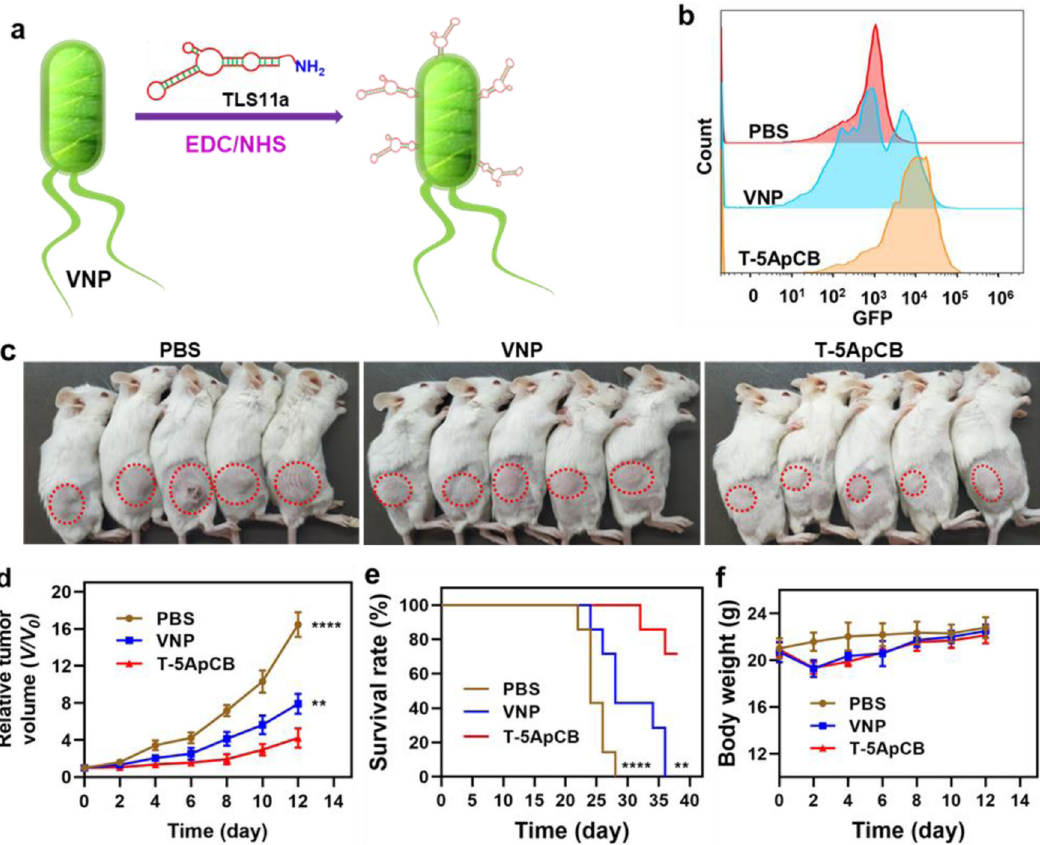
Fig. 6 Implementation of ApCB with aptamer TLS11a in an H22 tumor-bearing model. a Preparation of ApCB by conjugating VNP with TLS11a via amide condensation. b Flow cytometric analysis of H22 cells after co-incubation with PBS, VNP, and T-5ApCB respectively at 37 °C for 1 h. Flow plots are representative of three independent biological samples. c Digital photos of mice at day 12 after treatment. Tumors were marked in red circles. H22 tumor- bearing mice (inoculated with 1 × 10 6 carcinoma cells) were randomly divided into three groups and intravenously injected with PBS and 5 × 10 5 CFU of VNP or T-5ApCB upon tumor size reaching ∼ 100 mm 3 (de fi ned as day 0). d Relative tumor growth after different treatments ( n = 5). Data are presented as mean values ± SD. Signi fi cance was assessed using Student ’ s t test (two-tailed), giving p values: 0.000002 for T-5ApCB vs PBS; 0.0052 for T-5ApCB vs VNP. e Survival curves of H22 tumor-bearing mice after different treatments ( n = 7). Data are presented as mean values± SD. Signi fi cance was assessed using Student ’ s t test (two-tailed), giving p values: p < 0.0001 for T-5ApCB vs PBS; 0.0017 for T-5ApCB vs VNP. f Variation of bodyweight